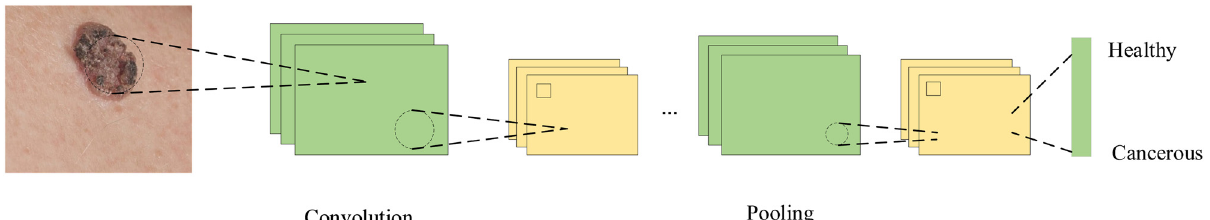
Figure 2: The structure of a